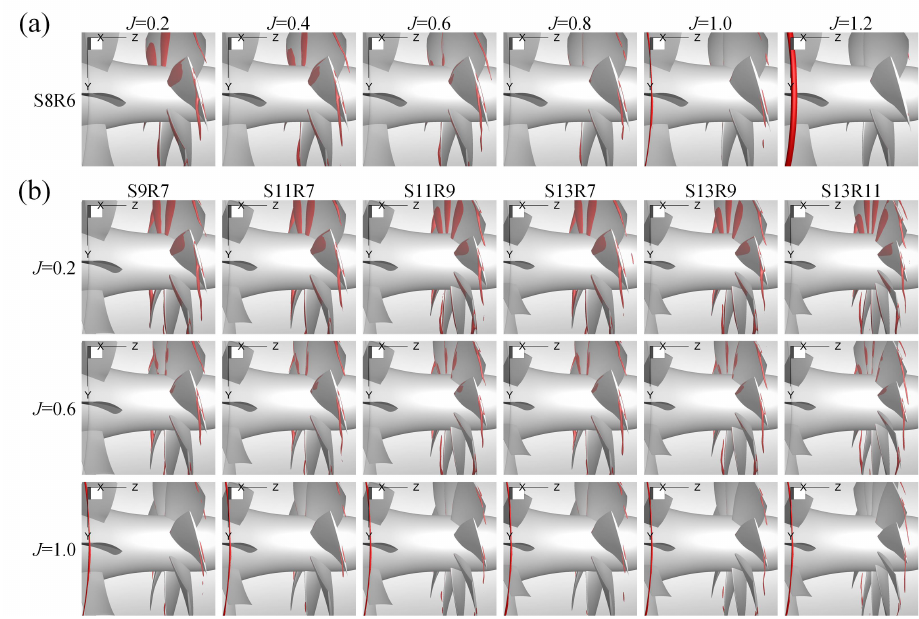
Figure 20. Pressure iso-surfaces ( C p = − 0.25) in the PJP flow region. ( a ) PJP model S8R6, ( b ) derived PJP models ID